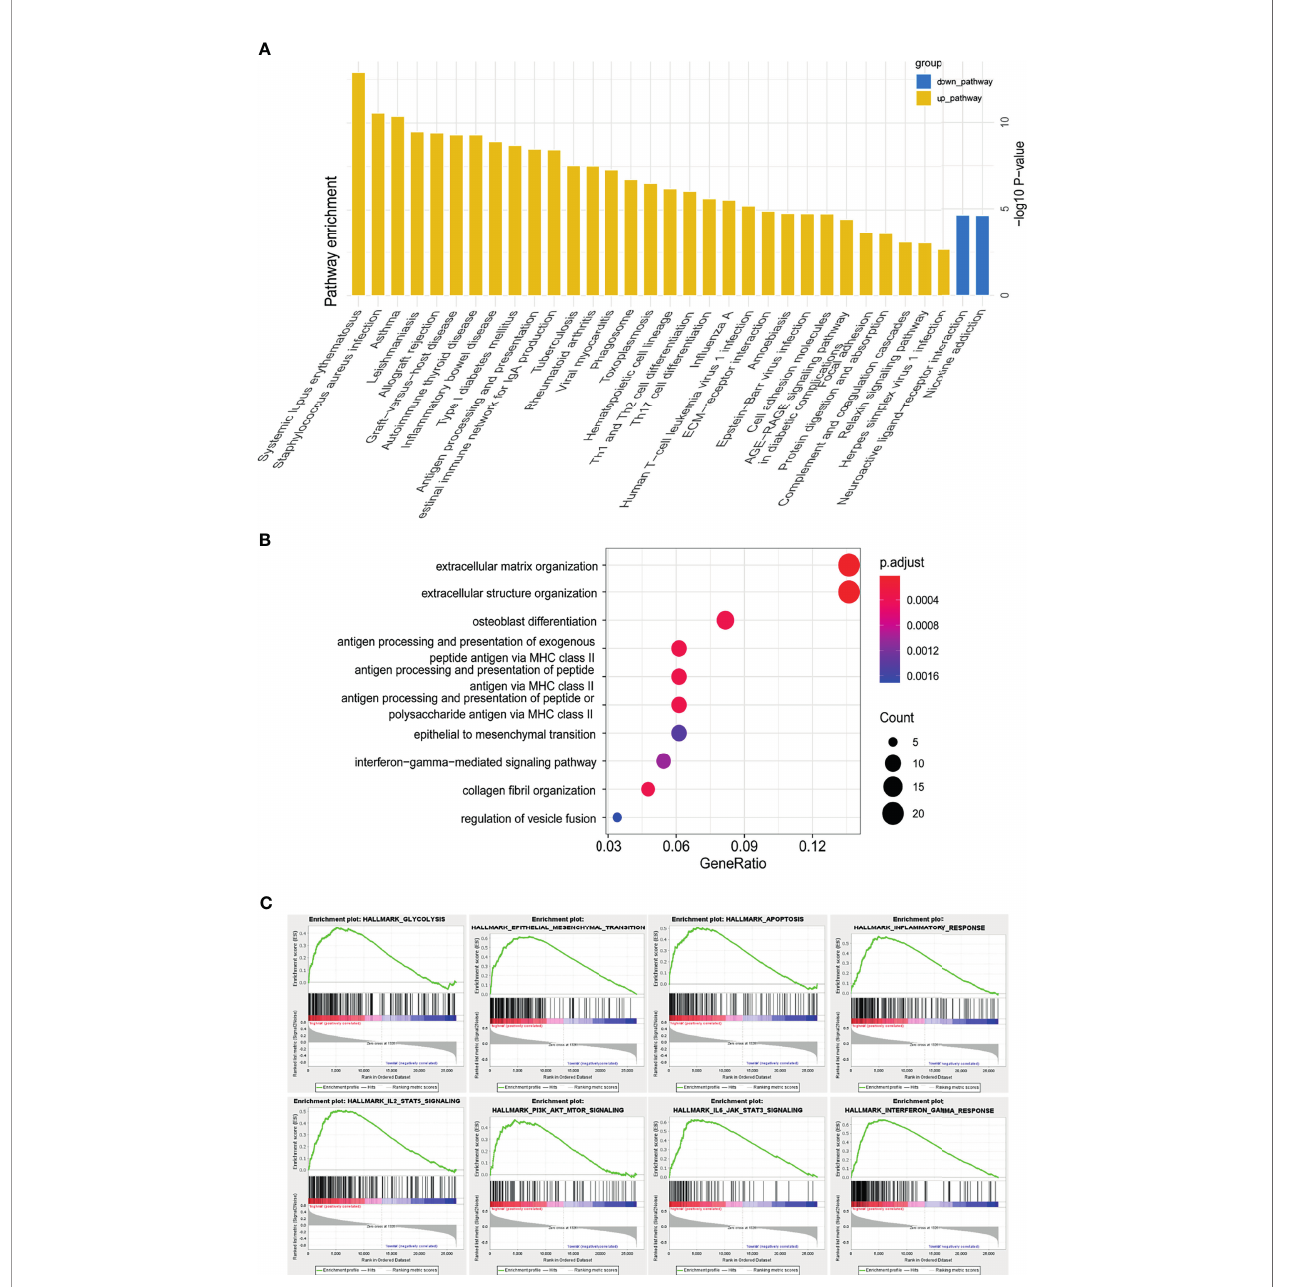
FIGURE 6 | Functional annotation of risk groups identi fi ed through the m5C LPS. (A) KEGG pathway enrichment analysis between high and low risk groups. (B) Dotplot of GO biological processes. (C) GSEA analysis showing pathways enriched in the high-risk